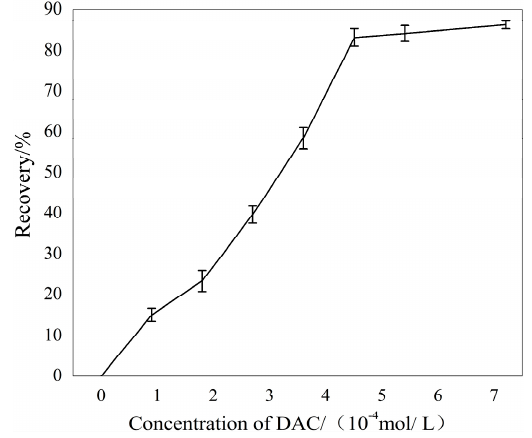
Figure 3. The flotation recovery of sillimanite as a function of dodecylammonium chloride (DAC) concentration at pH = 7.0.